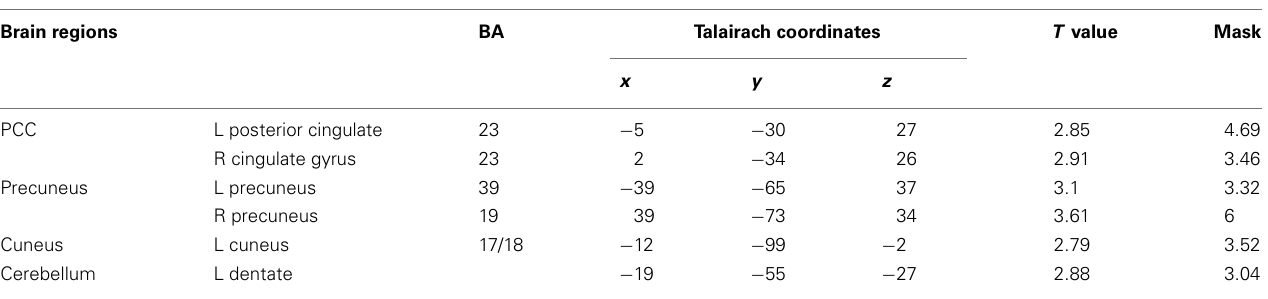
The table identifies brain regions mediating both successful coping with emotional distraction and EM enhancing effects of emotion by contrasting emotional (Emo) and neutral (Neu) items that were associated with WM success and were later remembered (WM-R and EM-R). Effects in the ventral affective (Emo WM-R and EM-R > Neu WM-R and EM-R) and dorsal executive (Neu WM-R and EM-R > Emo WM-R and EM-R) networks were masked by their corresponding a priori